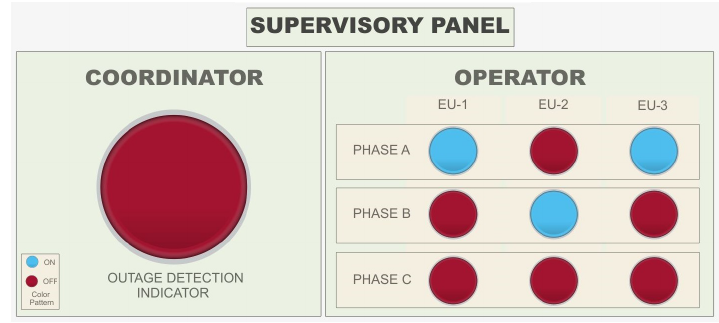
Figure 16. Presentation screen of the data concerning the result of the execution of the assay procedures (test algorithm) of the Outage Detection functionality.